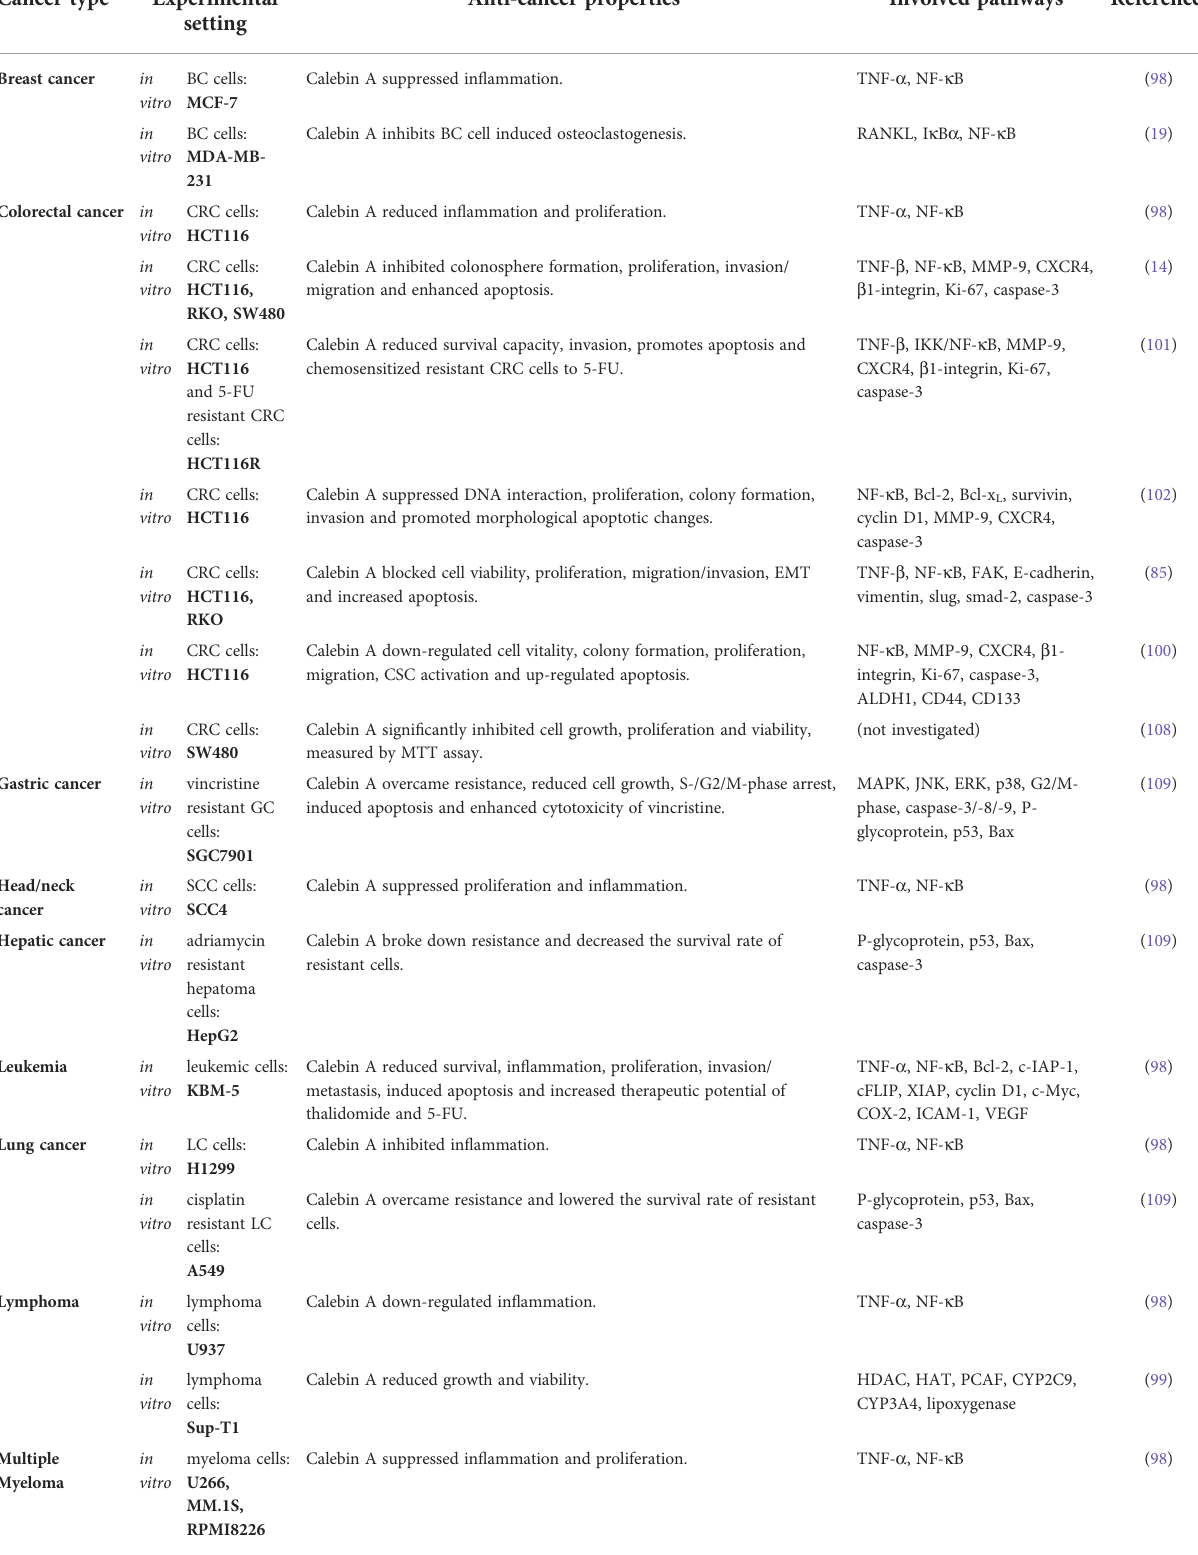
TABLE 2 Calebin A as anti-cancer agent. Cancer